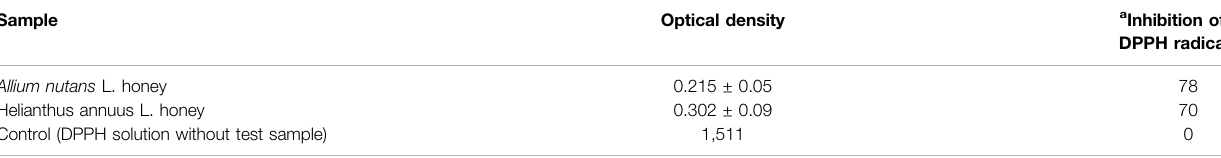
TABLE 2 | The values of the optical density of DPPH radical solution.